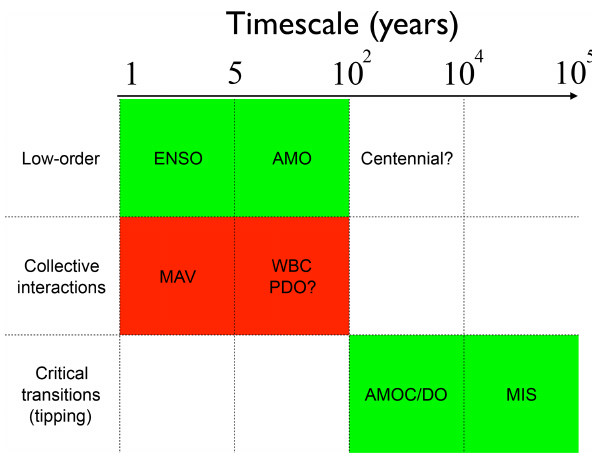
Figure 6. Summary of what has been learned from dynamical sys- tems analysis of spatially extended climate models, based on the distinction of low-order phenomena, emergent phenomena through collective interactions and critical transitions. The “hope” is that mechanisms of the phenomena in the green boxes can be deter- mined from numerical bifurcation analysis of intermediate com- plexity climate